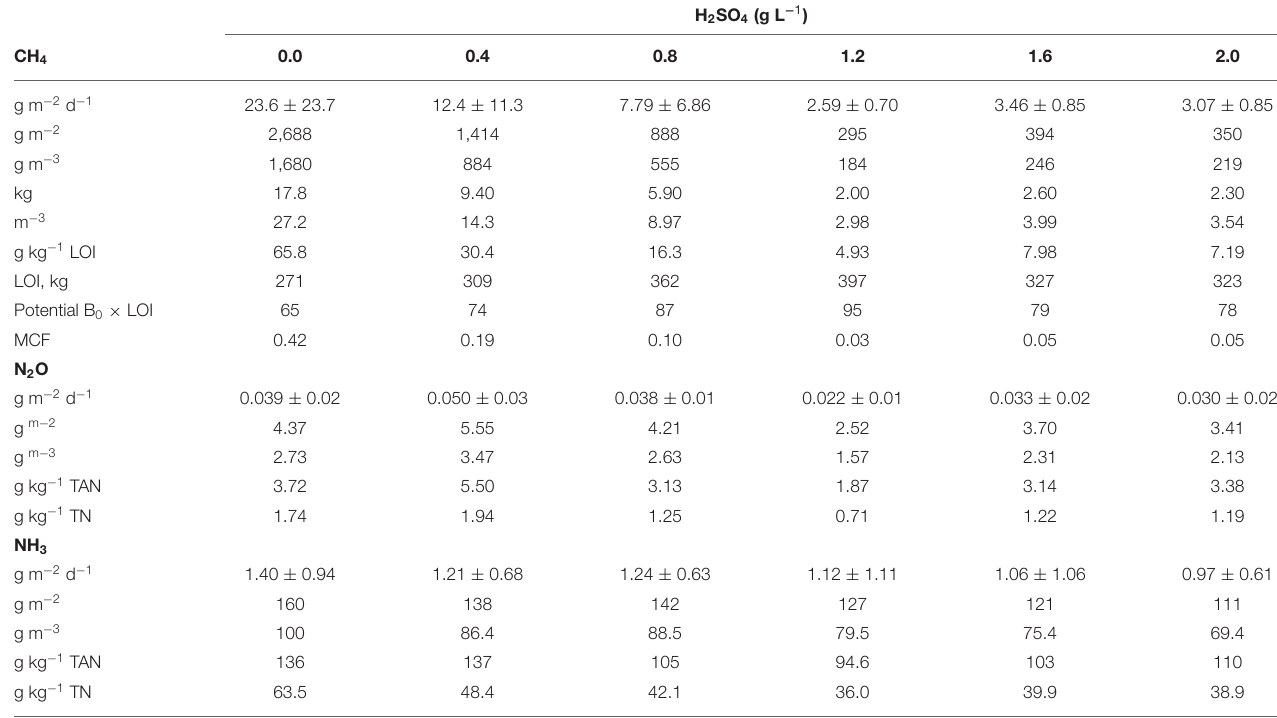
TABLE 2 | Methane (CH 4 ), nitrous oxide (N 2 O), and ammonia (NH 3 ) emissions from stored dairy manure treatments from start of trial (June 10) to trial end (Nov 2) expressed as cumulative (g m − 2 and g m − 3 ) and mean daily (g m − 2 d − 1 ± SD) emissions, as well as scaled cumulative CH 4 expressed as methane conversion factor (MCF) and scaled cumulative N 2 O and NH 3 emissions by total nitrogen (TN, g kg TN − 1 ) and total ammoniacal-nitrogen (TAN, g kg TAN − 1 ).